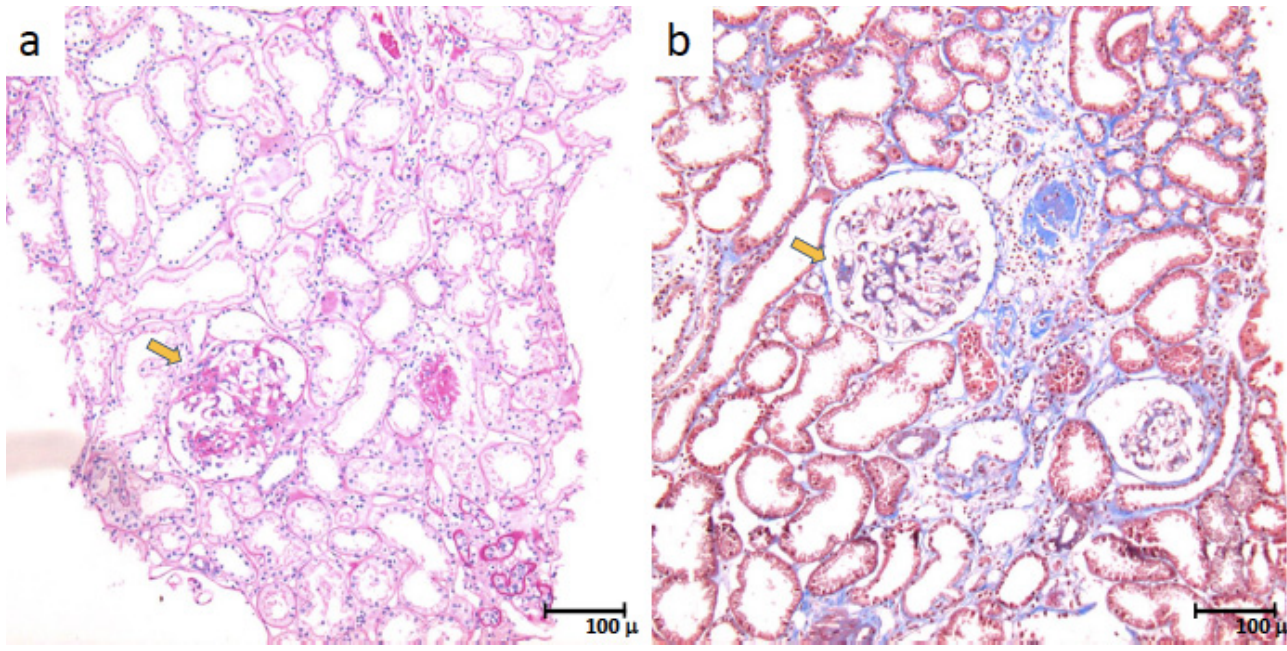
Figure 3. Photomicrographs at 100× stained with PAS ( a ) and Masson’s trichrome ( b ), respectively, in which the segmental lesions are indicated at low magnification (yellow arrows).